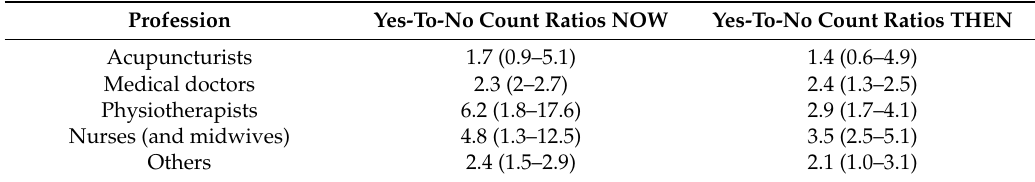
Table 5. Yes-to-No count ratios NOW and THEN, by profession, showing medians and IQRs.